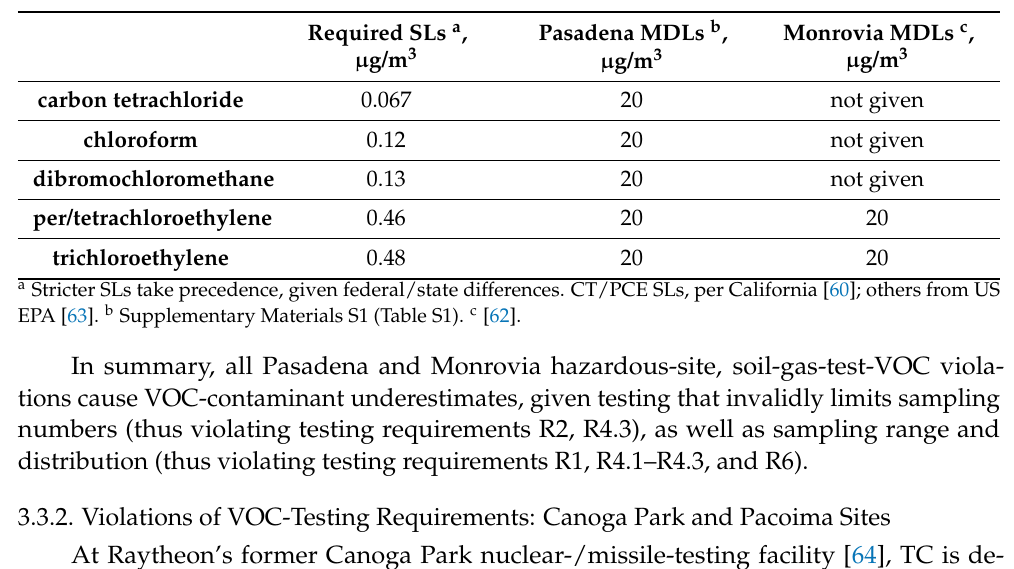
Table 4. Re R5, Pasadena and Monrovia, California waste-site testing used soil-gas VOC method- detection/reporting limits (MDLs) that fail required screening levels (SLs). The sites will be redevel- oped for 986 residential apartments.